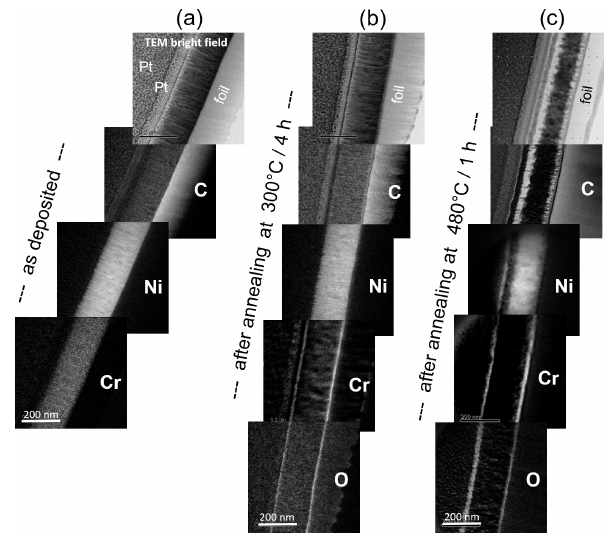
Figure 5. Elemental distribution study (EELS-EFTEM) on layers of Ni 90 Cr 10 -C on PI foil. (a) as-deposited (b) after annealing at 300 ◦ C per 4h (c) after annealing at 480 ◦ C per 1h. The upper pic- tures of each row represent a bright field image of a cross-section of the layer. Below, the element maps of C, Ni, Cr, O are arranged so that the cross sections continue in a line. The indicated element signal is shown in white color and means that the element is present at these positions. The scale bars have a length of